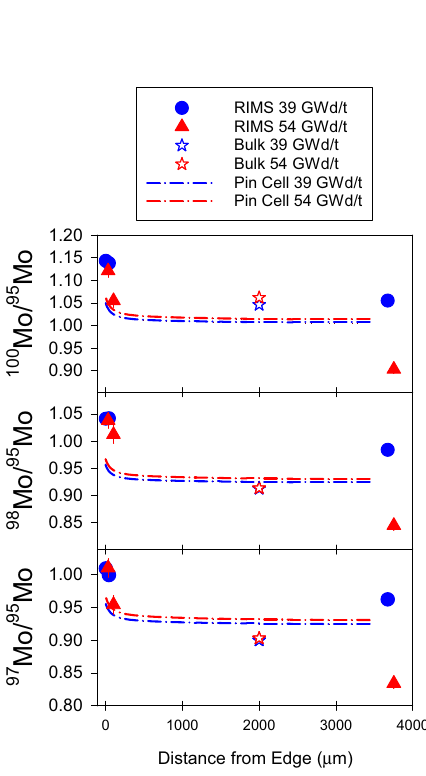
Figure 4. Mo isotope ratios as a function of radial position within a fuel pellet as measured by RIMS (filled symbols) and bulk analysis (open stars), and as calculated by a pin cell model (dash-dot lines). 1σ error bars are included but are generally smaller than the data symbols. Bulk analyses are arbitrarily set to a position of 2000 μm from the pellet